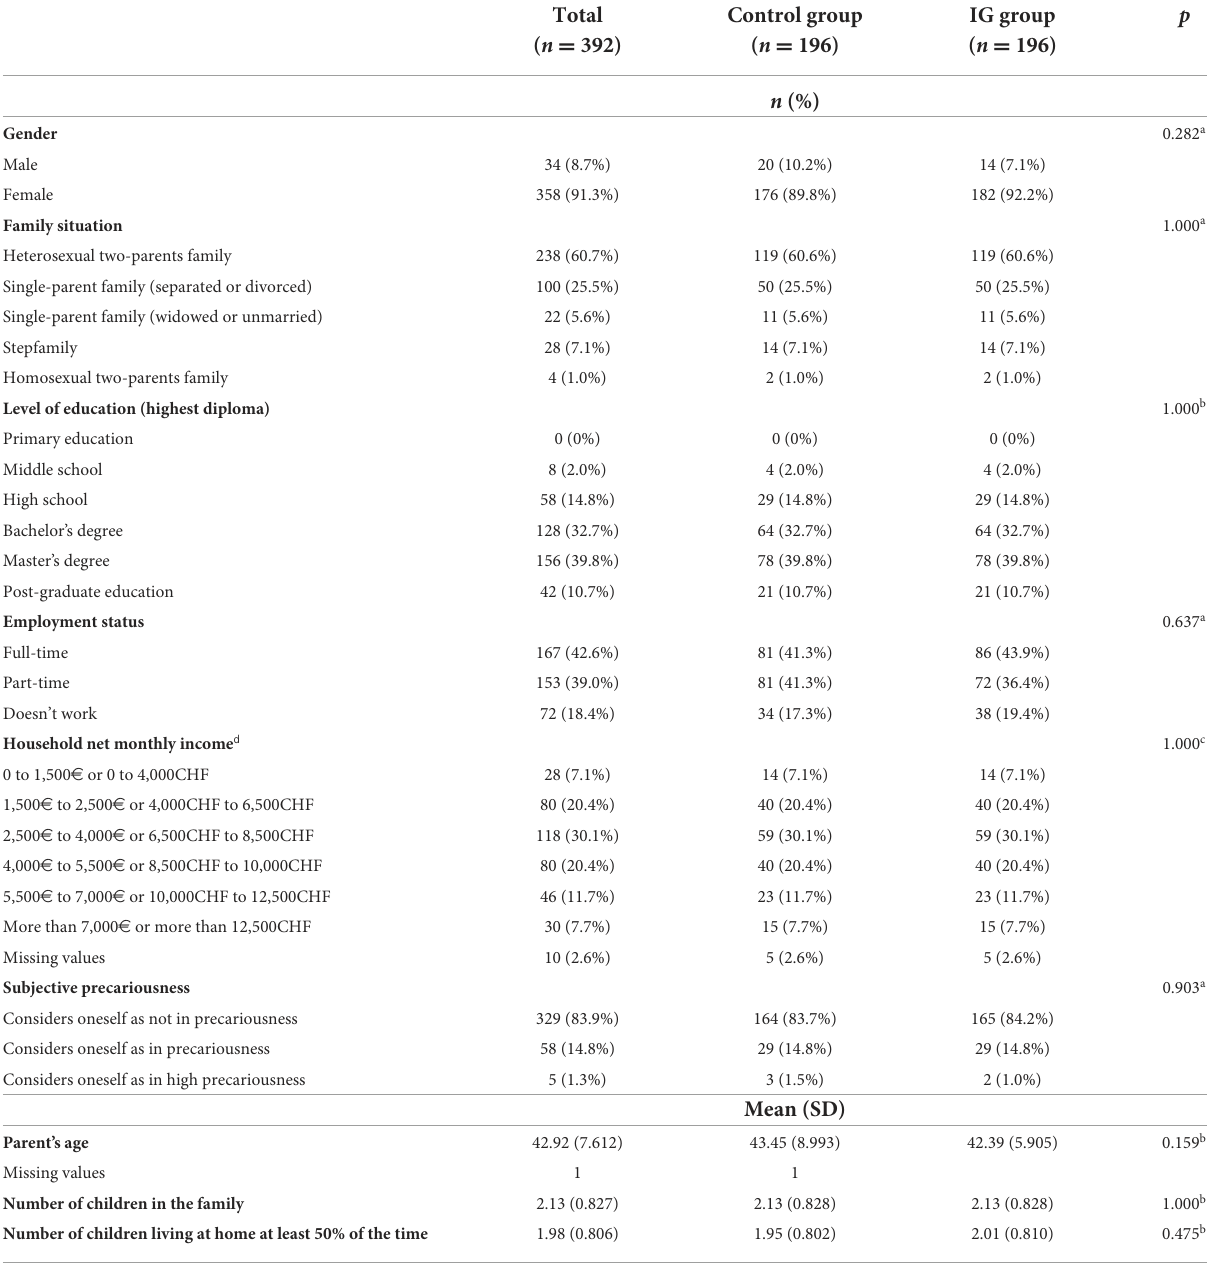
TABLE 1 Sociodemographic characteristics of the sample and equivalence of the control and IG